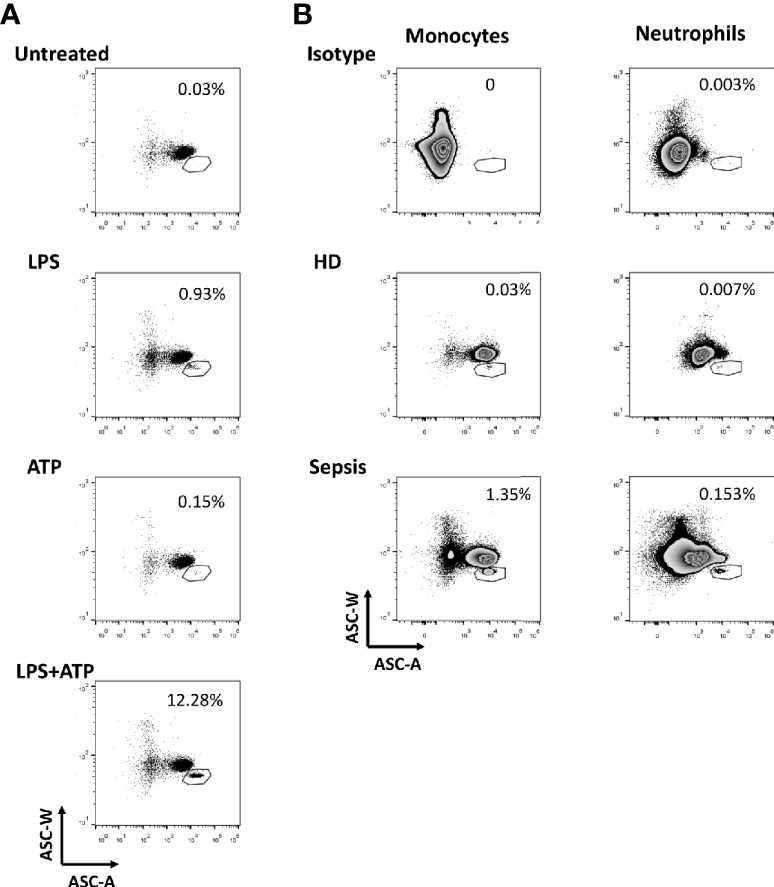
Formation of ASC-speck among leukocytes. (A) Detection of ASC-speck formation in peripheral blood mononuclear cells (PBMCs) of healthy donors after stimulation. Displayed are gated monocytes from gradient purified PBMCs (gating strategy is shown in
Supplementary Figure 2A
) cultured under different conditions including stimulation with lipopolysaccharides (LPS), with adenosine triphosphate (ATP) and with LPS + ATP. Gates were placed to include cells with a relatively low ASC-W: ASC-A profile (low W:A) that represent ASC-speck+ cells. Numbers shown next to the gates are the percentages of the ASC-speck+ cells from the HLA-DR+ monocyte population. Here, we confirmed that this flow cytometry assay allows the quantification of ASC speck-positive cells in samples. (B) Detection of ASC-speck formation in whole blood from sepsis patients and healthy donors. Displayed are gated monocytes and neutrophils from whole blood (gating strategy is shown in
Supplementary Figure 2B
). ASC-speck+ cells were defined by relatively low W:A in monocytes and neutrophils. Numbers shown next to the gates are the percentages of the ASC-speck+ cells from the HLA-DR+ monocyte and neutrophil population.